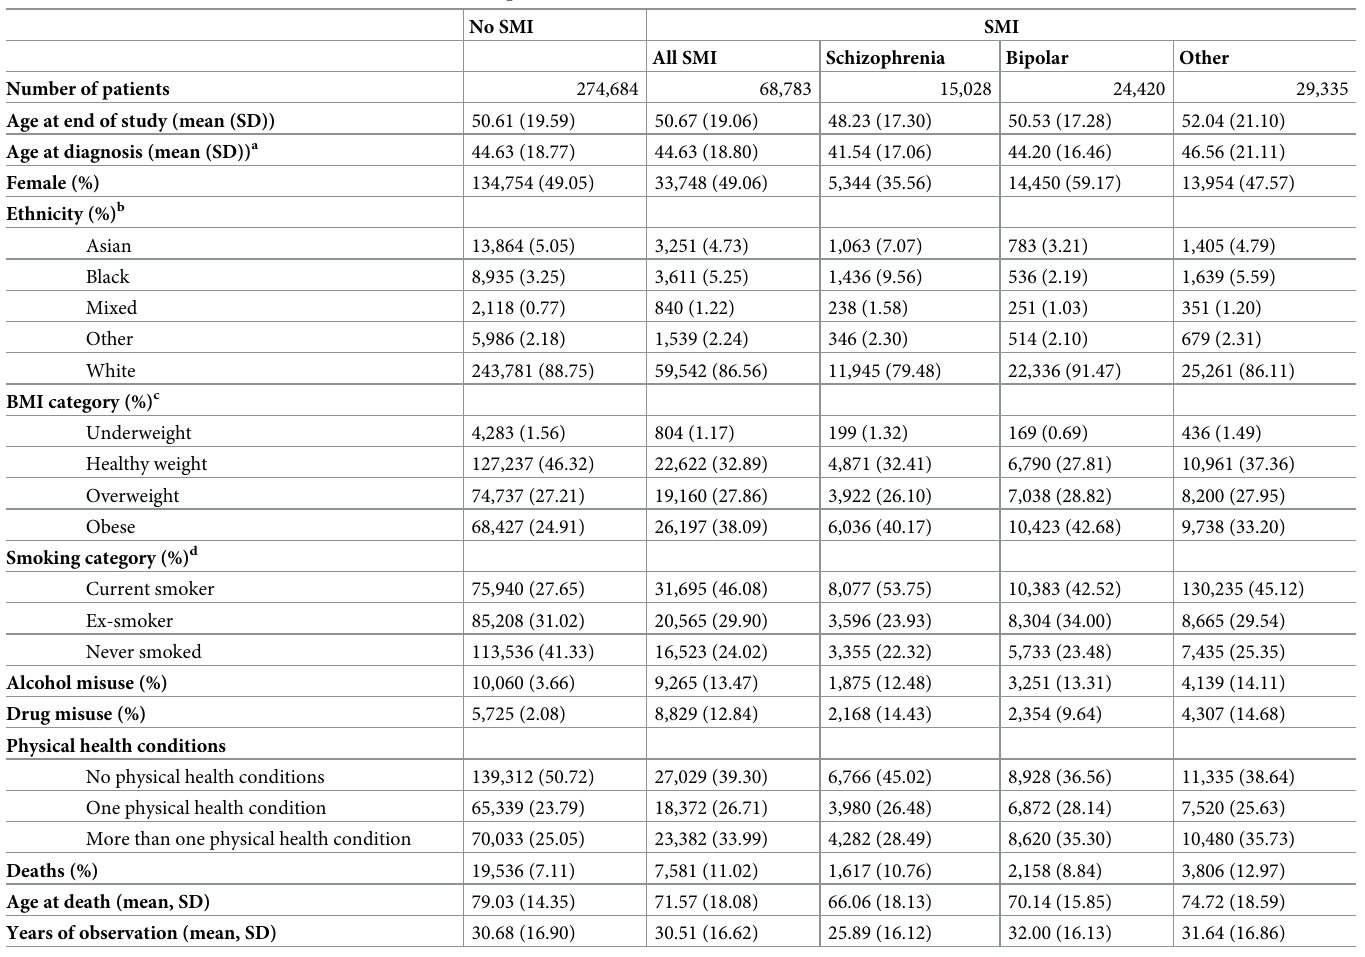
Table 1. Characteristics of the SMI cohort and matched comparators, n =